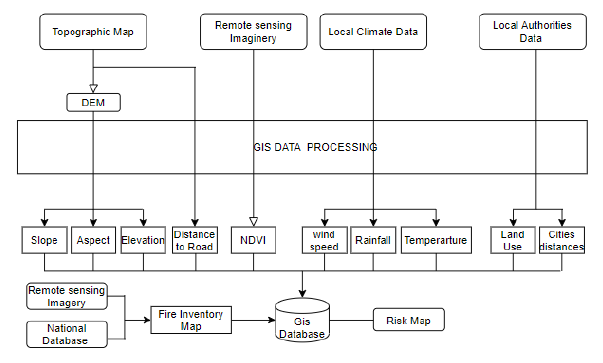
Figure 15. GIS Data processing The proposed methodology count five main steps: (1) Training; (2) Model design; (3) Optimization (4) Feature measurement and (5) Generation of the fire hazard map of the study